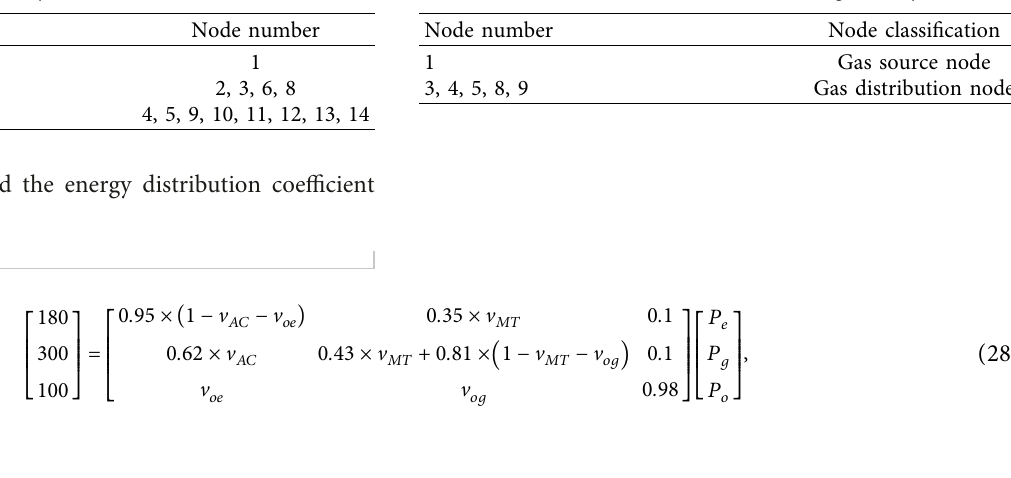
Table 5: Power system node classification. Table 6: Node classification of natural gas